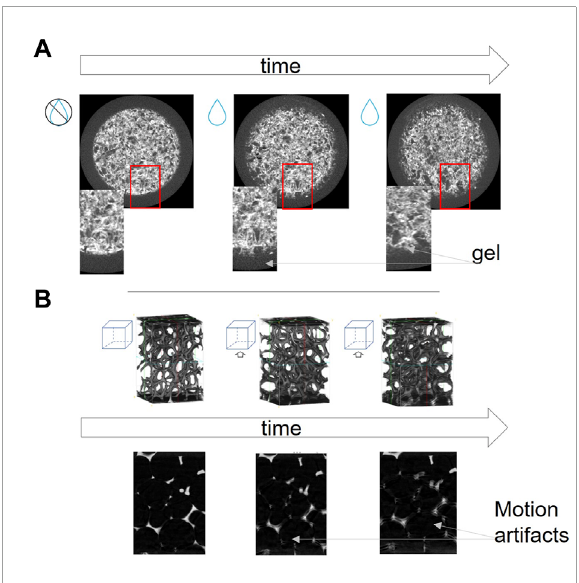
FIGURE 2 (A) Central slice (658 × 658 voxels) of the pharmaceutical tablet before the experiment (dry condition) and during the experiment. The images show the presence of gel at the edges of the tablet. (B) Volumes and central slices (401 × 601 voxels) of the aluminum foam sample before and during the compression experiment. The aluminum foam dataset is an artificially slowed down dynamic acquisition of the sample during compression, which is why motion artifacts are present in the